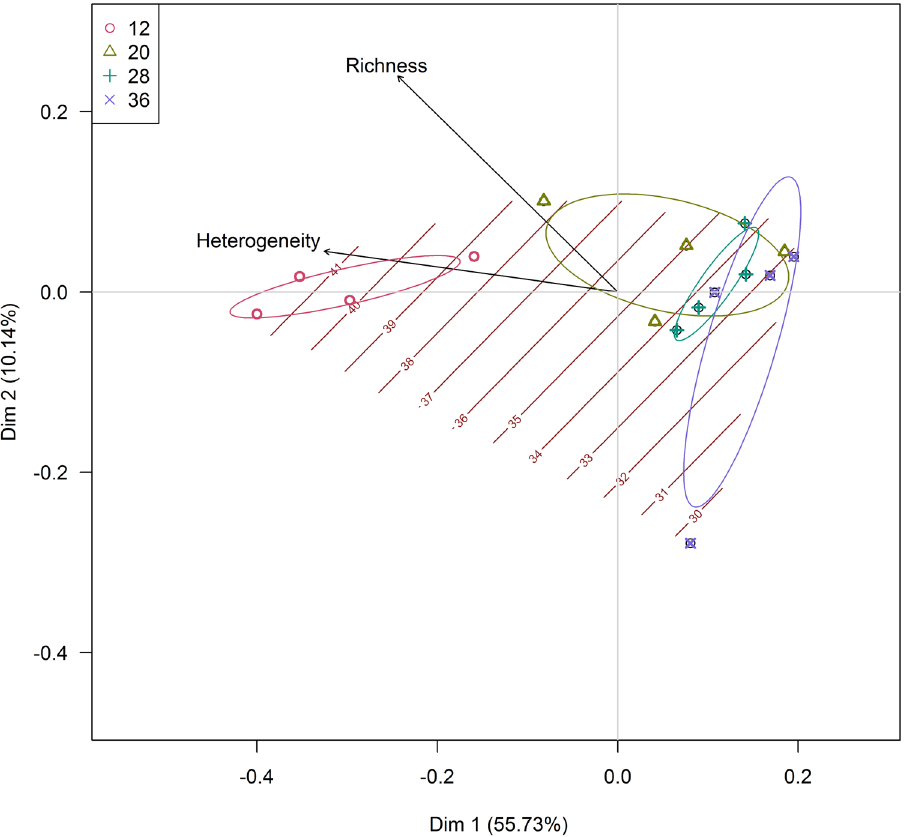
Figure 3. Principal coordinate analysis (PCoA) with ordination for species richness (Richness) and structural heterogeneity (Heterogeneity) at the plot level of 4 m 2 , in a Highland grassland dominated by Andropogon lateralis Nees managed at different canopy heights. The grading levels relate to the number of species and the ellipses to the treatments. The Bray–Curtis method was used, with a restricted maximum likelihood value for species richness of 44.63. This figure was created by the authors using the R environment version 4.1.0 (https:// www.R- proje ct. org/), the vegan version 2.5-7 (https:// CRAN.R- proje ct. org/ packa ge= vegan) and